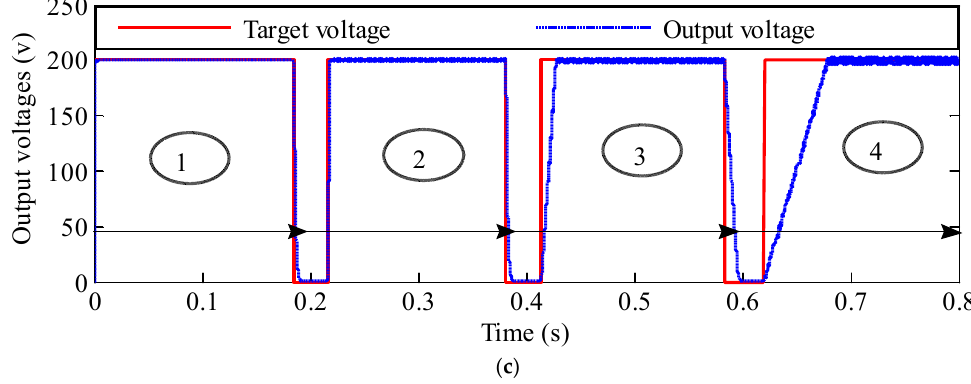
Figure 7. Discontinuous function coefficient effect: ( a ) evolution of M coefficient, ( b ) evolution of the control voltage and ( c ) evolution of the output voltages.